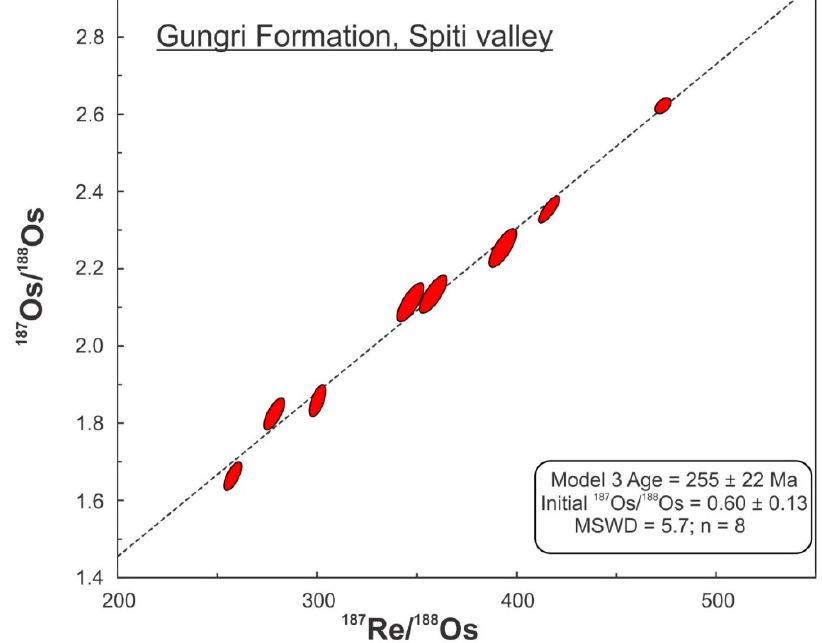
Figure 3. 187 Re– 187 Os isochron for the black shales from the Gungri Formation, Spiti Valley yields an age of 255 ± 22 Ma (2 σ ; n = 8; MSWD ~ 5.7). Table 2. Elemental and Sr isotopic data for carbonate samples from the Mikin Formation, Spiti valley. Sample ID